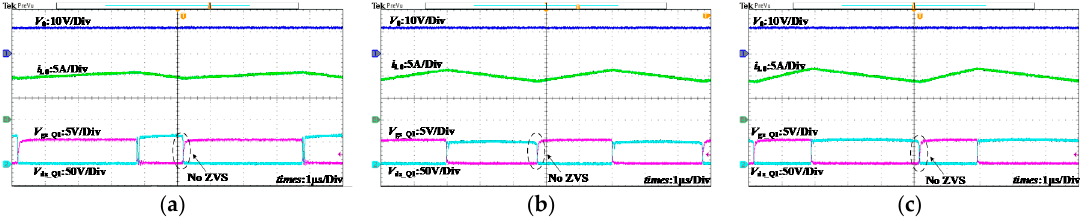
Figure 9. Measured waveforms of output voltage V 0 , inductor current i L0 , and MOSFET Q 1 under different input voltage: ( a ) V in = 18 V; ( b ) V in = 28 V; ( c ) V in = 36 V.